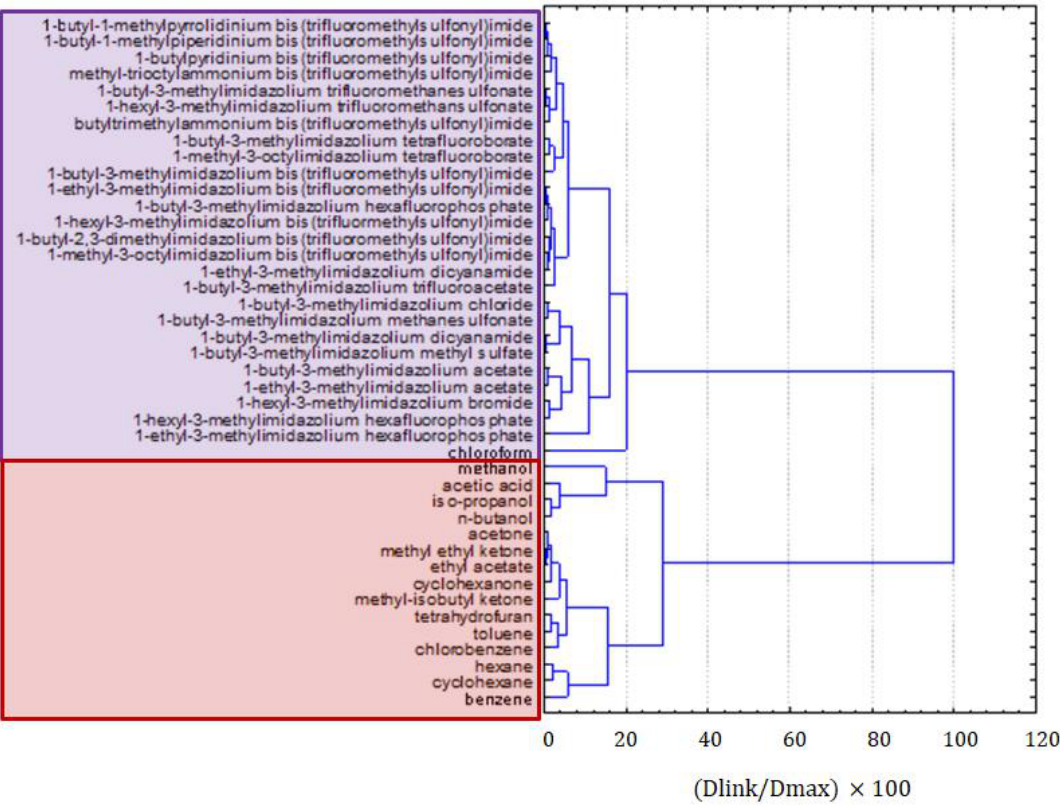
Figure 2. The hierarchical dendrogram for all 42 organic compounds characterized by 12 variables.